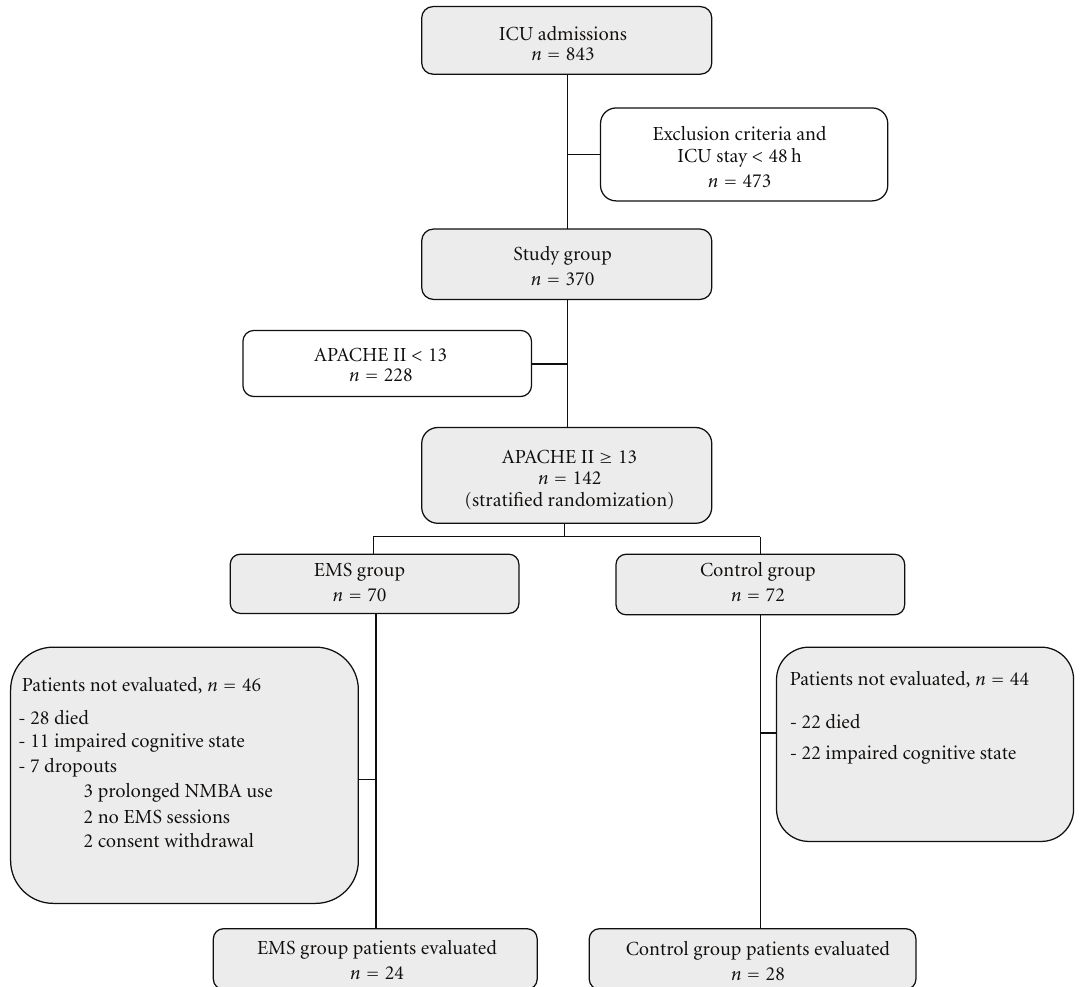
Figure 1: Flow chart diagram of the patients admitted to the ICU during the 30-month study period. NMBAs: neuromuscular blocking